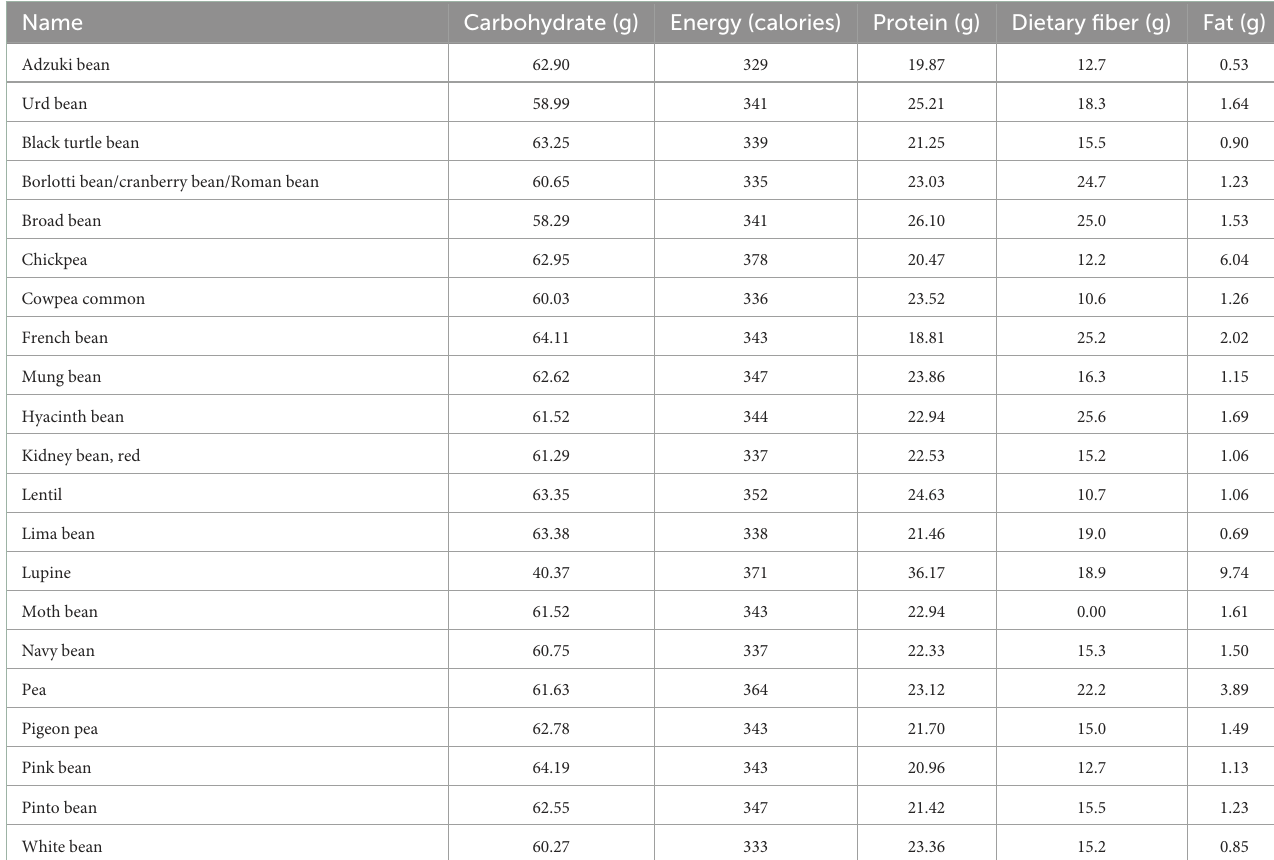
TABLE 4 Energy profile of common pulses ( https://www.nutritionvalue.org